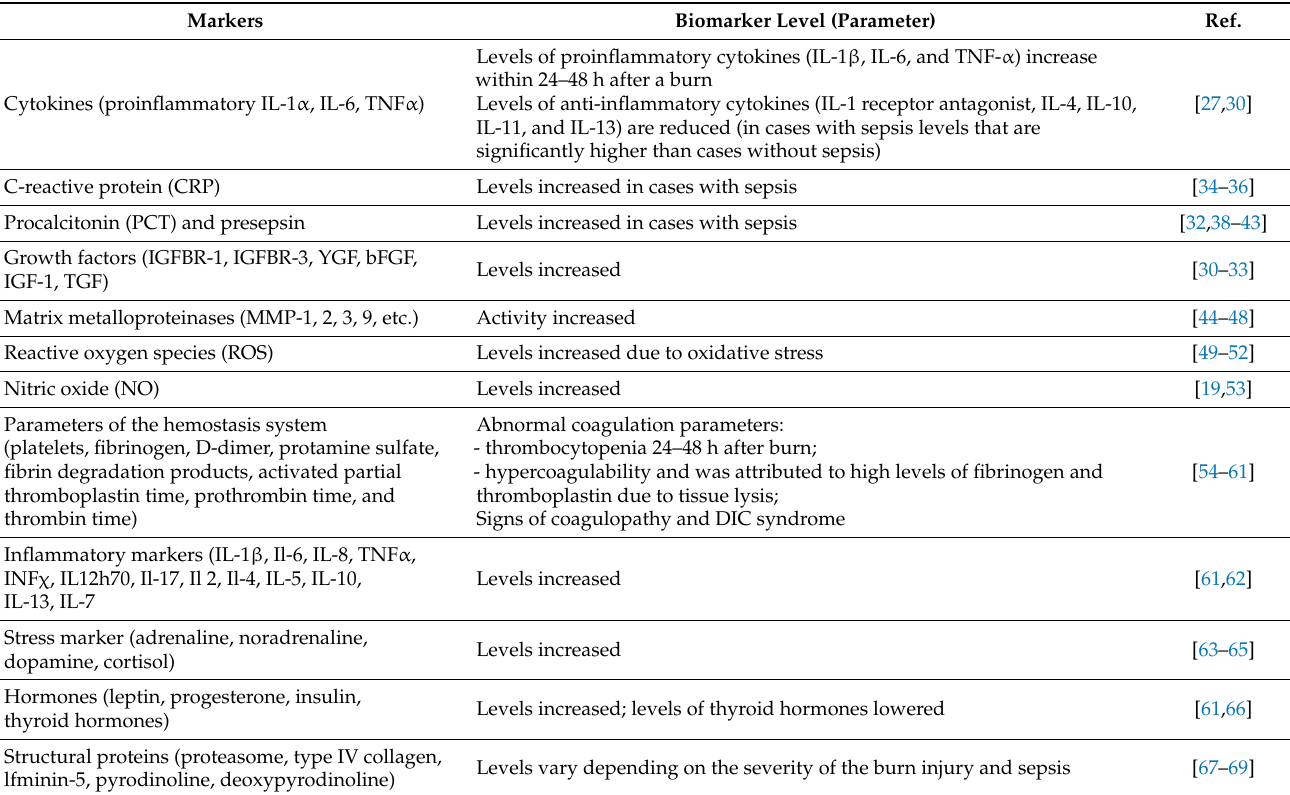
Table 1. Immunobiochemical markers of severe burn injury and burn